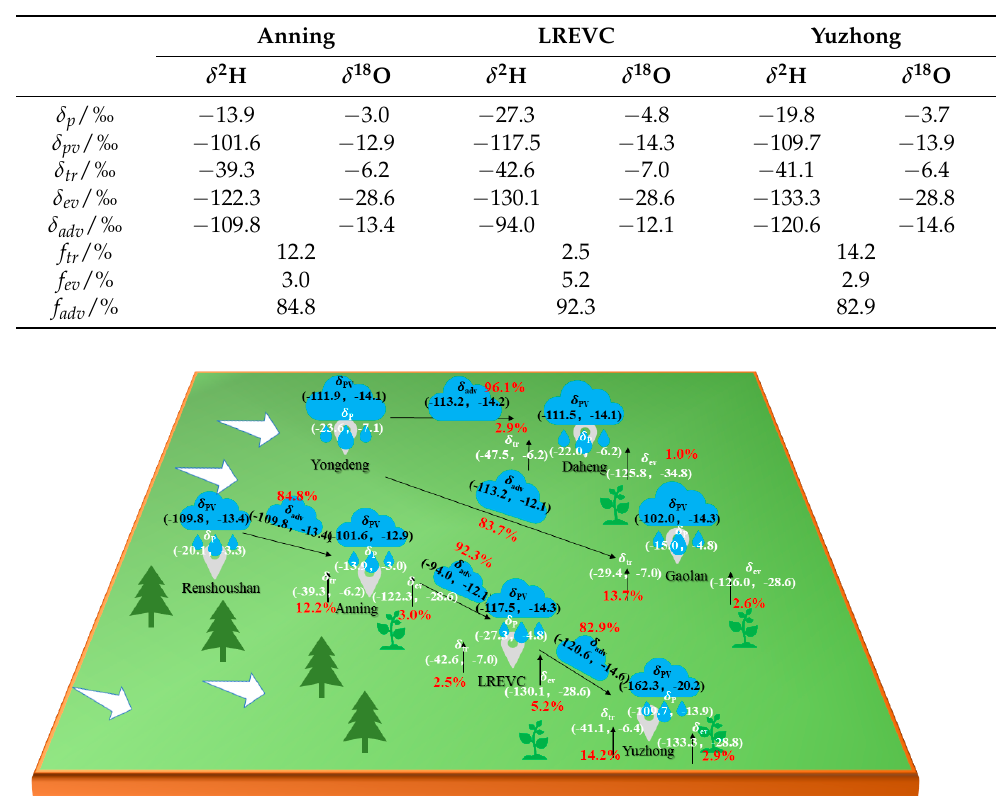
Table 2. Proportions of advected and recycled water vapor along the path of Renshoushan–Anning– LREVC–Yuzhong in summer.